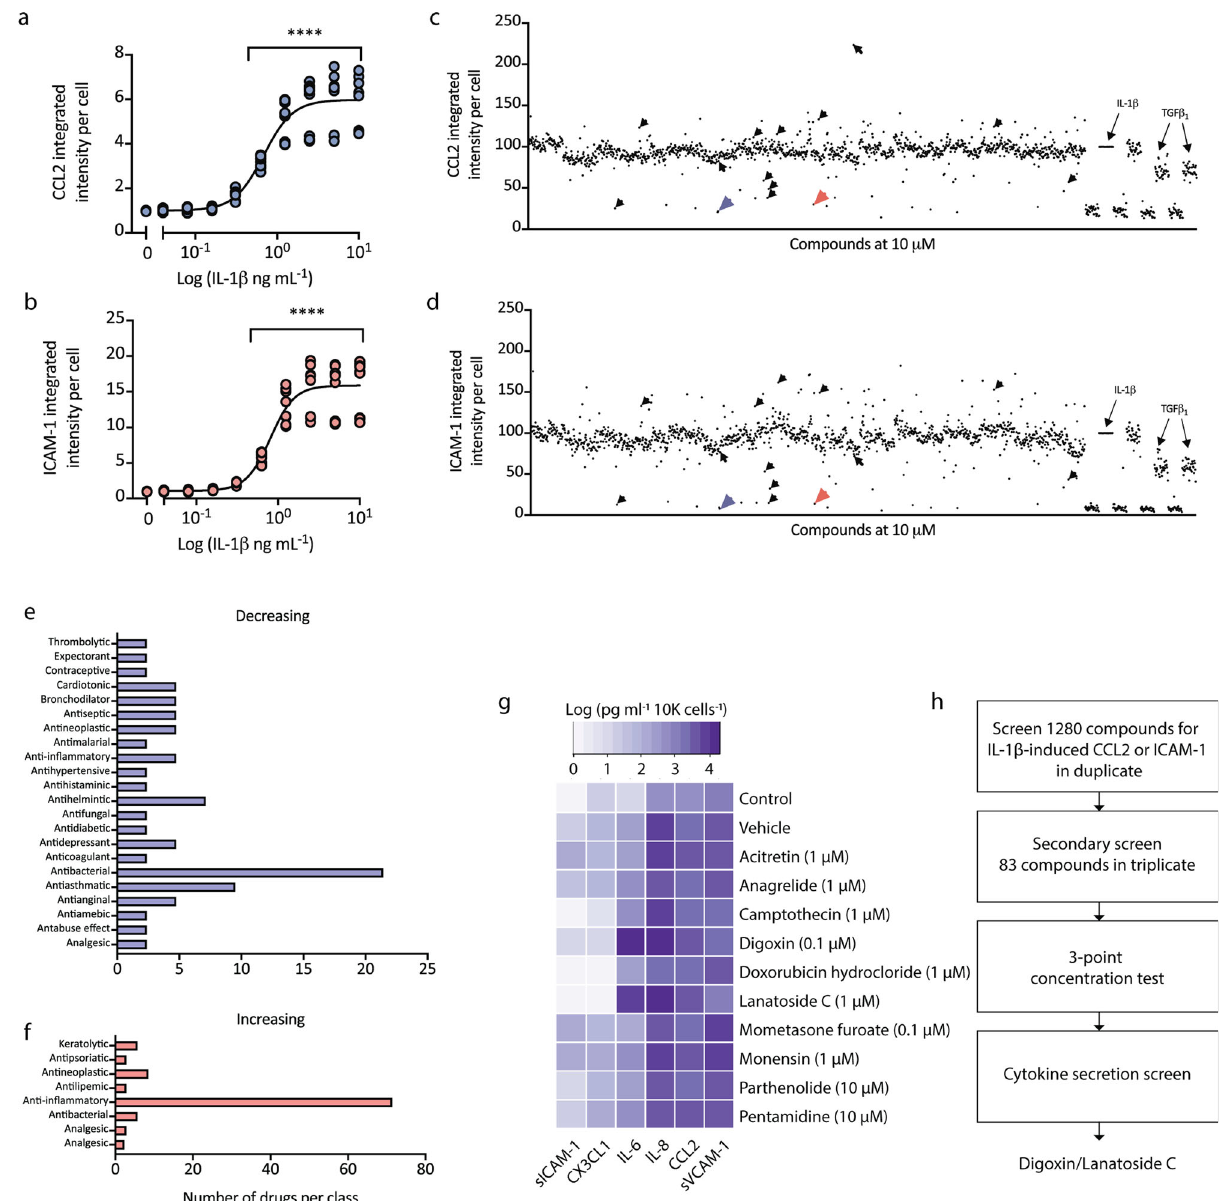
Fig. 1 High throughput screening of pericytes identi fi es in fl ammatory-modulating compounds. a, b Pericytes were treated with IL-1 β for 24 h and immunostained for CCL2 and ICAM-1 protein expression. Integrated intensity per cell was calculated using total cells (Hoechst), n = 3, signi fi cance determined using one-way ANOVA with Dunnett ’ s correction for multiple comparisons, mean ± SEM.**** p < 0.0001. Case used H239. c , d Pericytes were screened for compounds that can modify IL-1 β -induced CCL2 or ICAM-1 expression using the Prestwick chemical library. Mean integrated intensity per cell was calculated using total cell counts and normalised to IL-1 β + vehicle condition (arrow) (blue arrow-digoxin, red arrow-lanatoside C, black arrows-hit compounds tested in ( g )). Internal controls were present on each drug plate (TGF β 1 , 1 or 10 ng mL − 1 ). Case used: H239. e , f Hits identi fi ed using cut-off criteria from primary screen that modi fi ed CCL2 or ICAM-1 expression with known therapeutic uses. g Conditioned media from pericytes pre-treated with hit compounds for 24 h, then stimulated with IL-1 β (0.05 ng mL − 1 ) for 24 h was analysed by CBA, data was normalised to cell number and presented as the logged value of cytokine secretion in pg/mL/10,000 cells. Control (0.01% BSA in PBS) + dimethylsulfoxide (DMSO), Vehicle (IL-1 β (0.05 ng mL − 1 + (DMSO)), remainder are IL-1 β + drug ( n = 2, media pooled from triplicate wells for analysis). Cases used E206, E213. h Drug screening pipeline in primary human brain pericytes. Initial screen in pericytes completed in duplicate wells and secondary screen in 83 compounds that met cut-off criteria was completed in triplicate wells. Effects that were reproduced were examined using a three-point concentration test, then tested for effects on cell secretion (data in Fig. scores 44 were also calculated to measure plate variability for the adhesion molecule expression in pericytes 43 (Fig. 1c, d). Plates were internally normalised to account for plate variability in CCL2 and ICAM1 induction, returning values of 0.43 and 0.15, terms of cell numbers and absolute intensities, and the IL-1 β respectively (Fig. S1). This analysis shows that CCL2 expression is induction of CCL2 or ICAM-1, and the TGF β 1 -dependent more consistent across plates than ICAM1, and therefore a inhibition was consistent across all test plates (Fig. S1). Z - superior assay measure. Despite this difference in Z -scores when